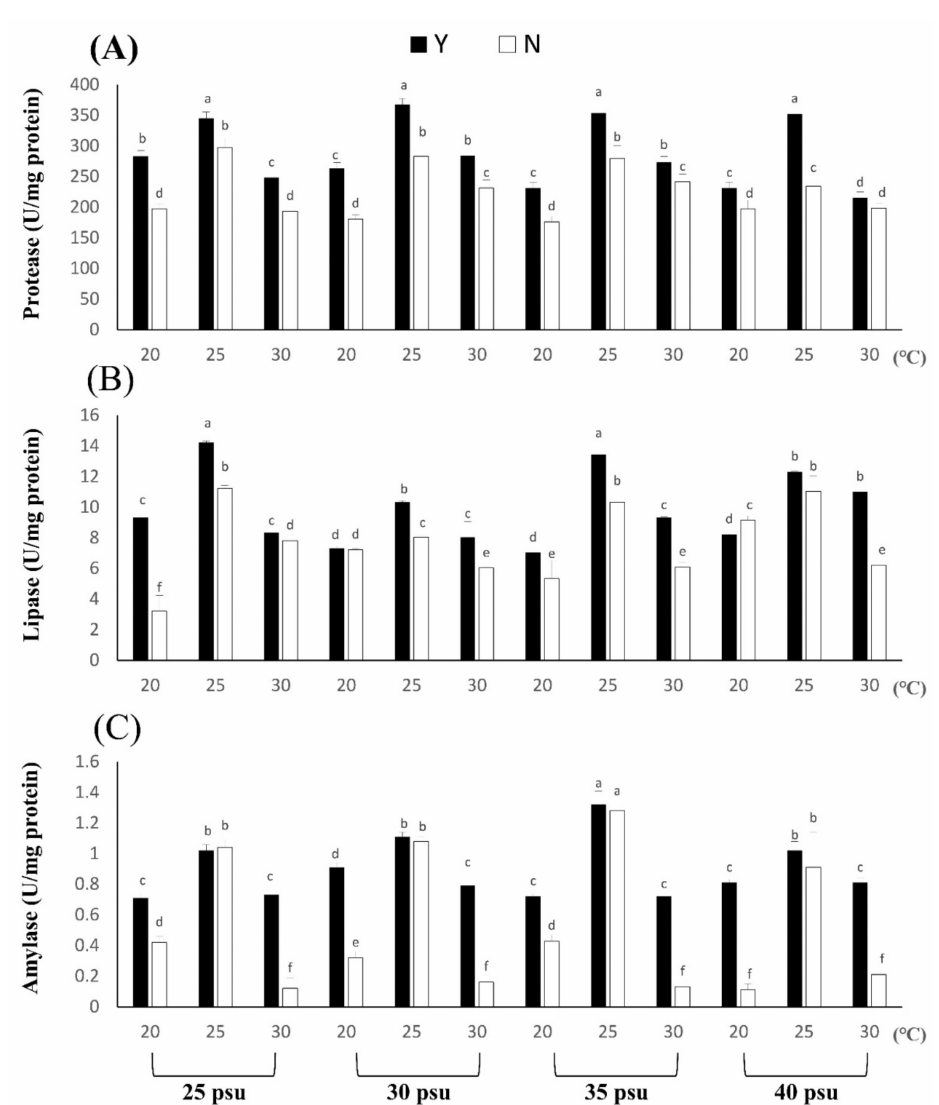
Figure 4. The effect of feeding on Briareum violacea digestive enzymes during temperature and salinity stress. Different Latin alphabet letters indicate significant differences among groups ( p <